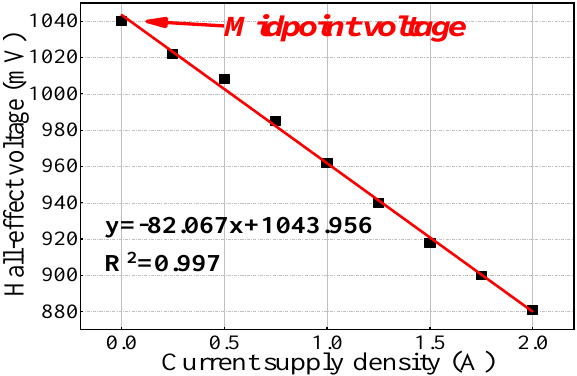
Figure 4. Calibration process of homemade apparatus.